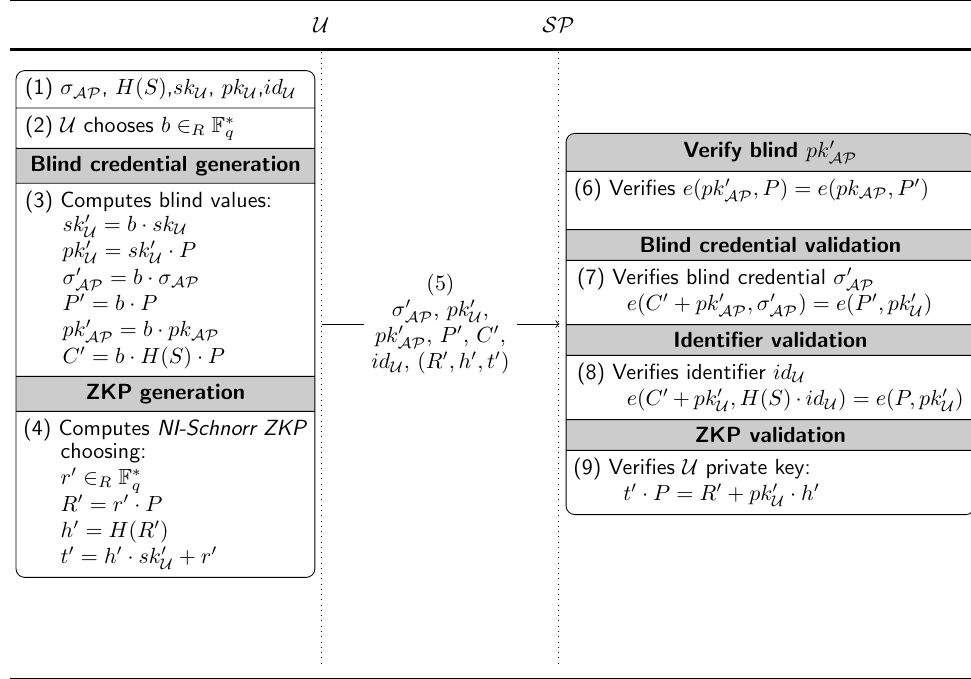
Figure 3. Message exchange between